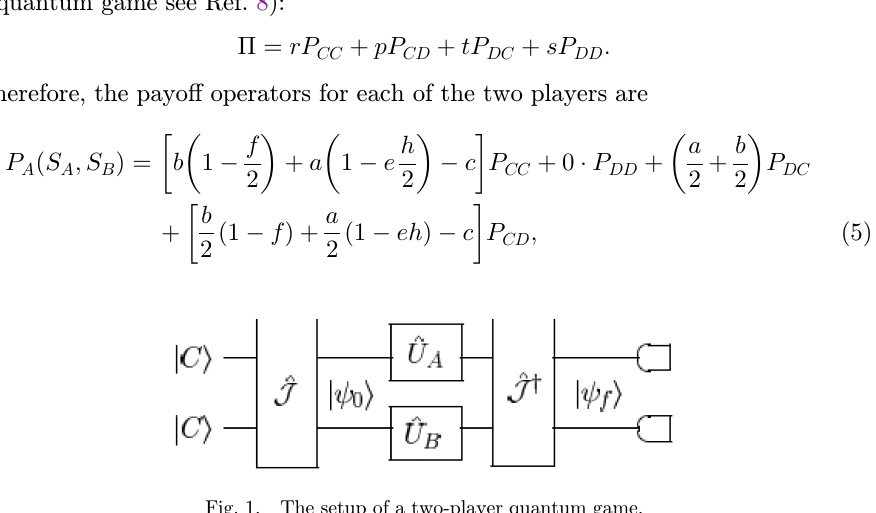
Fig. 1. The setup of a two-player quantum